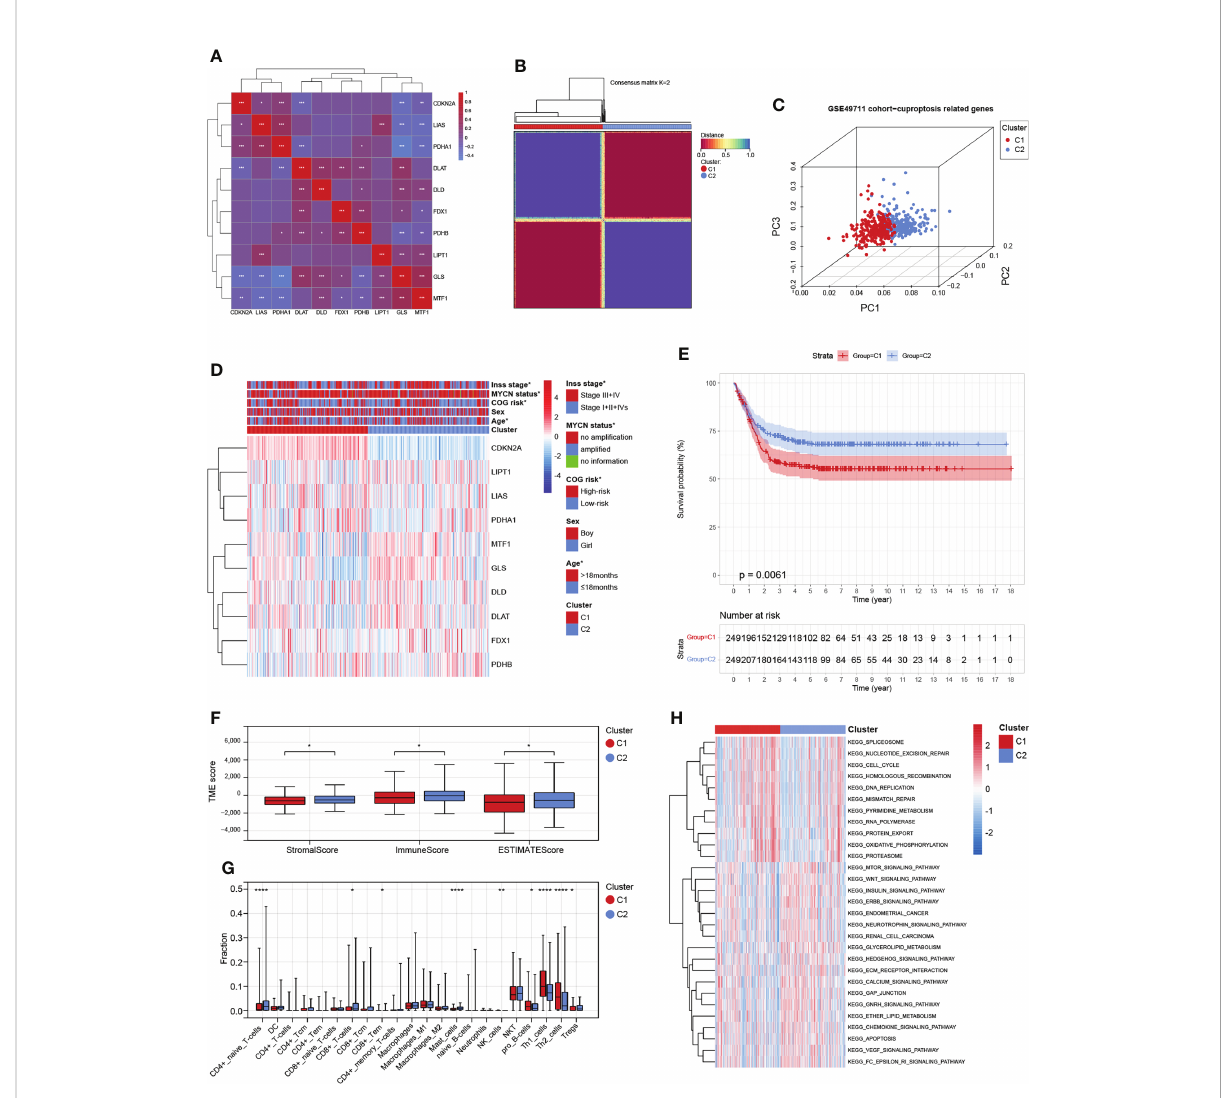
FIGURE 2 Identi fi cation and comprehensive analysis of cuproptosis subtypes in NB. (A) Expression-related clustering heat map of 10 cuproptosis-related genes. (B) Consistency of clustering results in heatmap (k = 2). Rows and columns represent samples, the different colors represent different types. (C) PCA analysis shows a remarkable difference in transcriptomes between the two subtypes. (D) Heatmap of the clinical correlation between the two subtypes in NB. (E) Patients in cluster C1 exhibited worse progression-free survival compared to those in cluster C2. (F) Estimatescore, Immunescore, and Stromalscore in the two subtypes. (G) Distribution of 22 types of immune-in fi ltrating cells in the two subtypes. (H) GSVA of biological pathways between the two distinct subtypes. *, **, ***, and **** indicate a signi fi cance level of 0.05, 0.01, 0.001, and 0.0001,